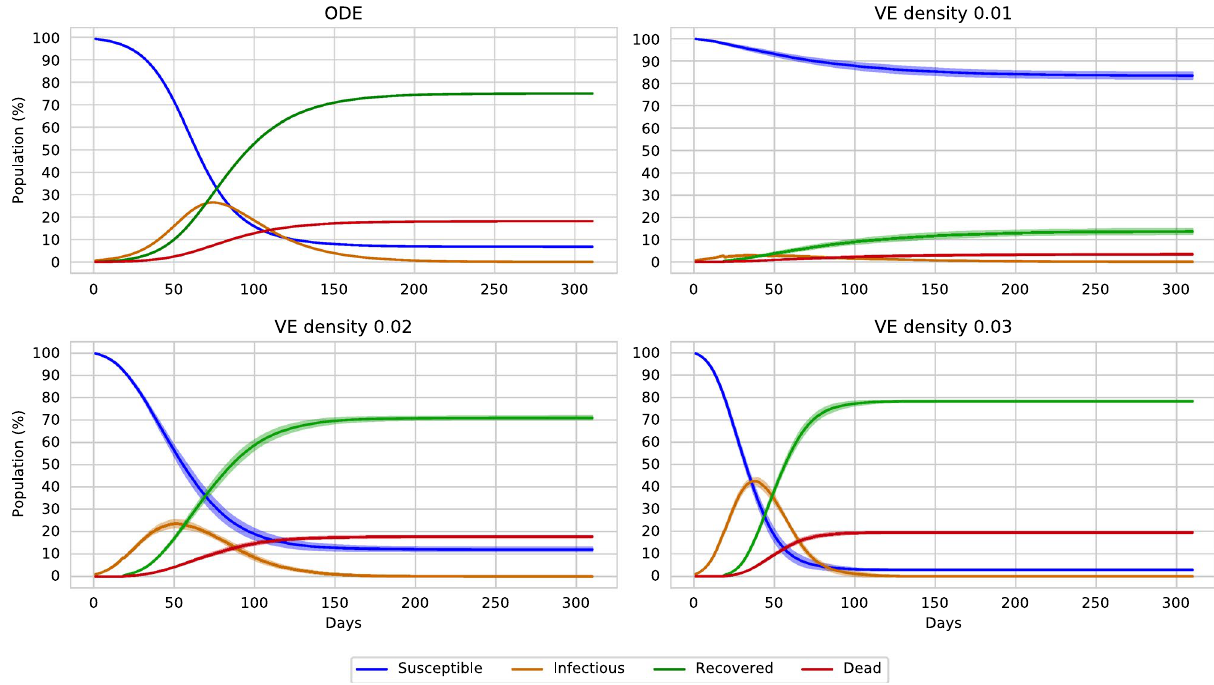
Figure 8. The graph illustrates a comparison of ODE with virtual environment models. The upper left graph shows the ODE variables. The upper right graph shows the virtual environment with a density of 0.01. The lower graphs represent the virtual environment of densities 0.02 and 0.03, respectively. The 0.02 and 0.03 density environments closely relate to the ODE